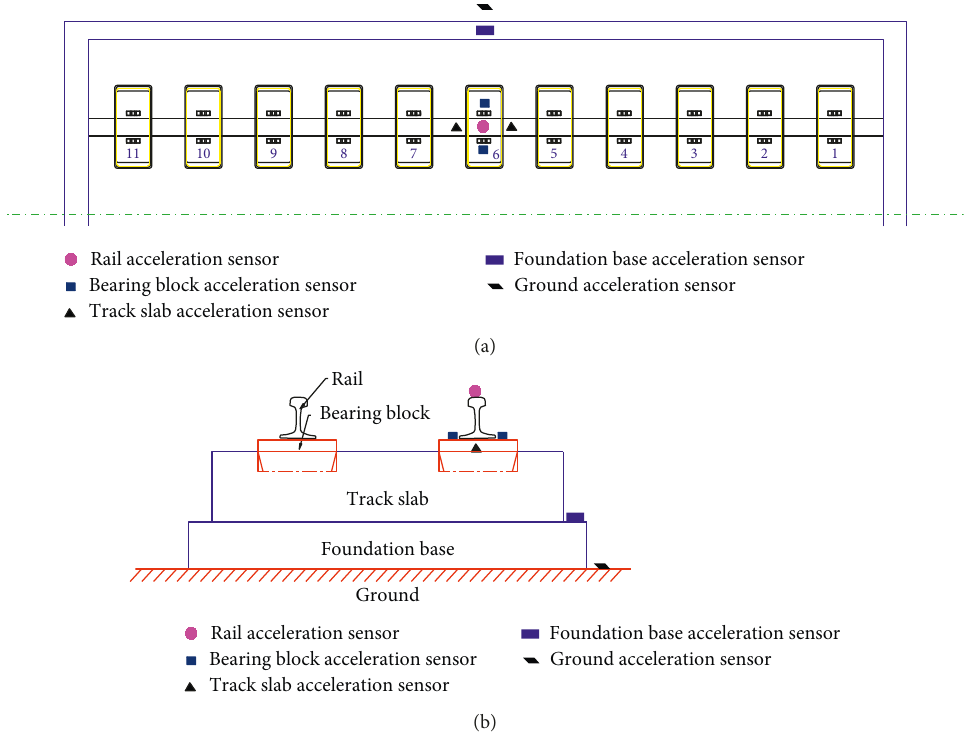
Figure 7: Vertical acceleration sensors arrangement along the track vertical line. (a) Top view. (b) Side view.